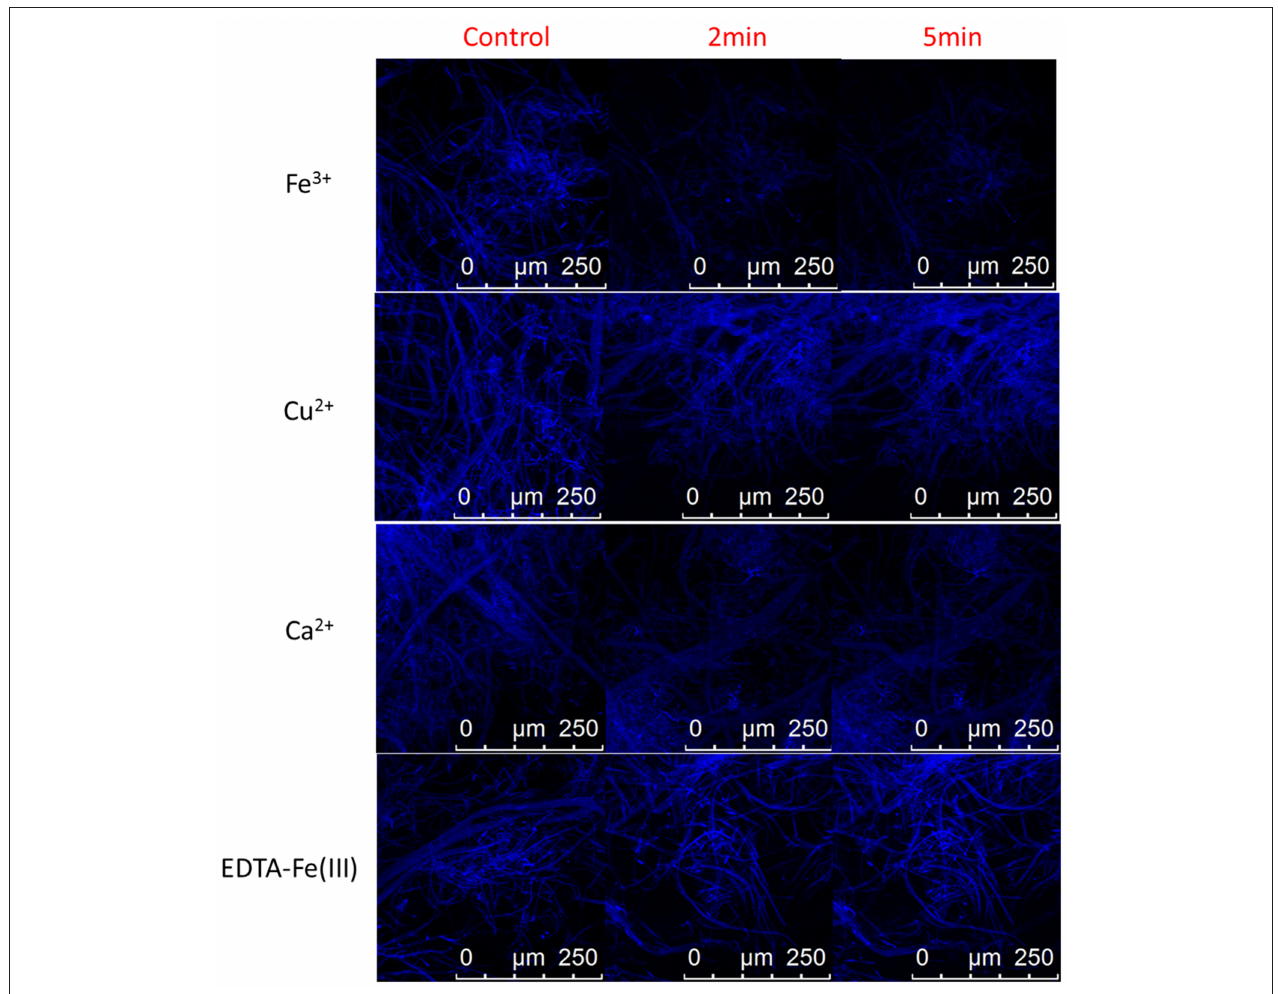
FIGURE 6 | Representative confocal fluorescence images of plant pathogenic fungal cells ( C. gloeosporioides ) labeled with the carbon dots in Tris-HCl buffer solution (control) and Tris-HCl buffer solutions of 0.005M Fe 3 + , Cu 2 + , Ca 2 + , and EDTA-Fe(III) complex.